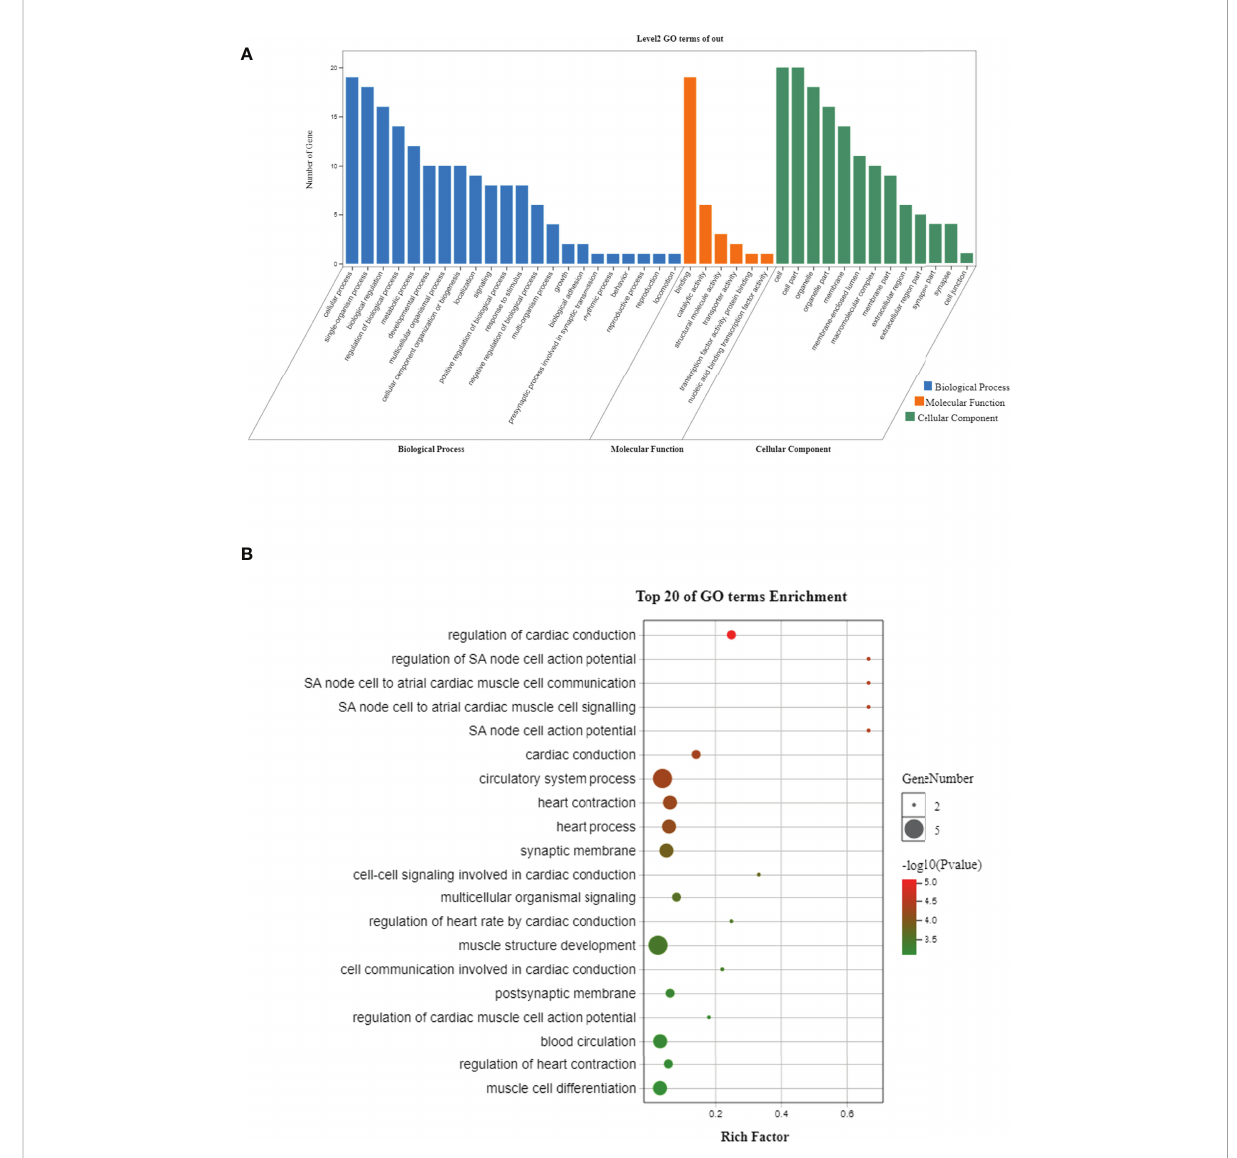
FIGURE 2 Histogram (A) and bubble plot (B) of Gene Ontology enrichment for the annotated similar